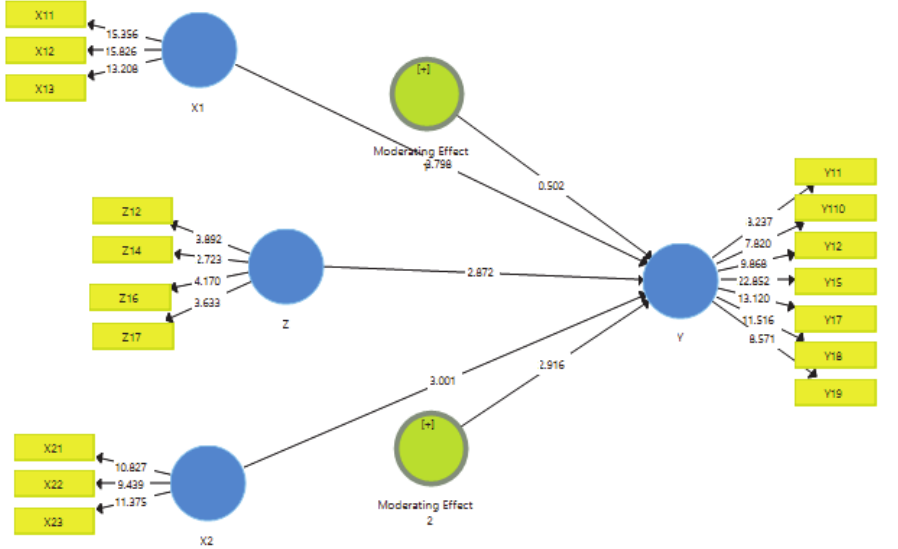
Fig. 1. Structural Test